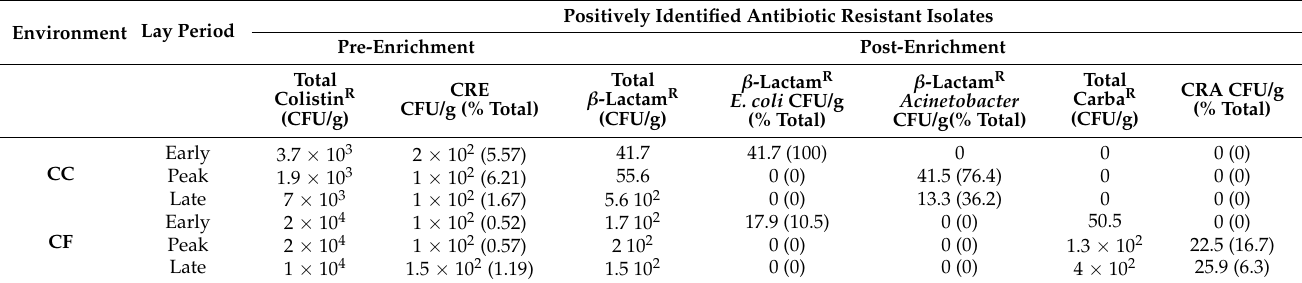
Figure 2. Prevalence of colistin-resistant bacteria in CC and CF. Total colistin-resistant bacteria were counted and Log 10 CFU/g were calculated for each lay period in both environments. Table 2. Antimicrobial resistant bacteria detected in CC and CF Environments.